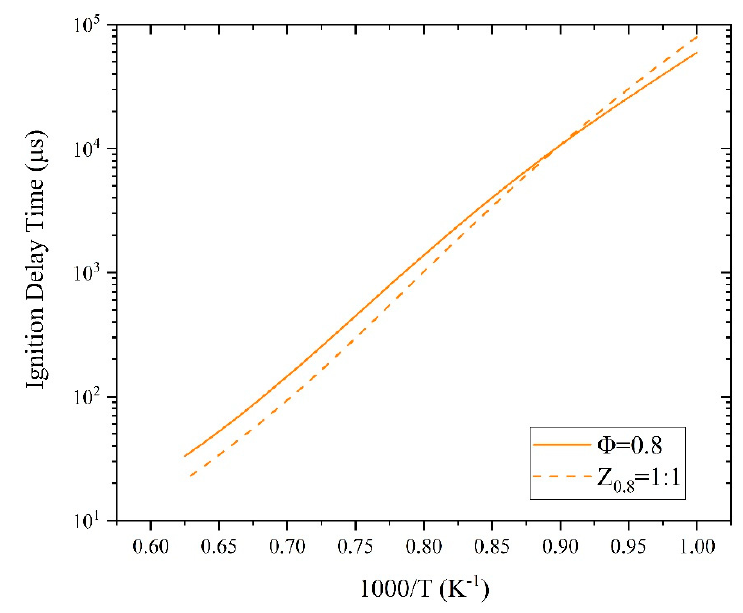
Figure 2. Comparison of the ignition delay times of n -pentane at an equivalence ratio of 0.8 and air– light hydrocarbon mixing gas at a mixing degree of 1.